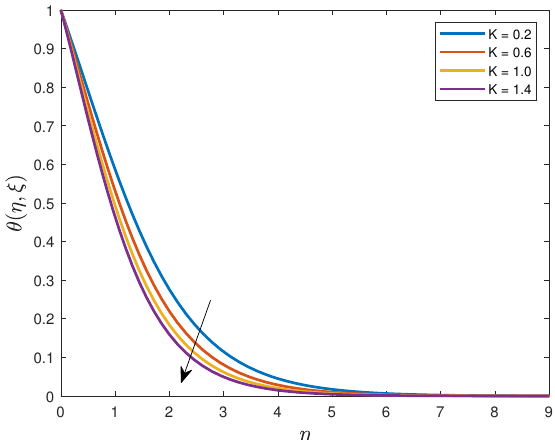
Figure 8. The influence of K on fluid temperature.